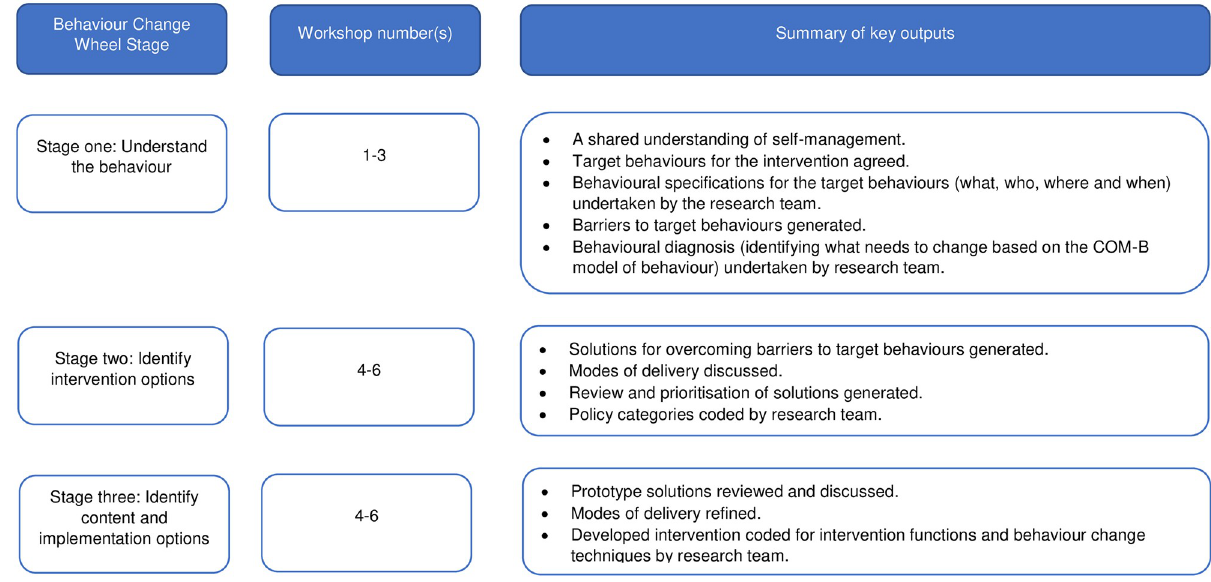
Fig 2. Summary of key outputs linked to stages of intervention development.